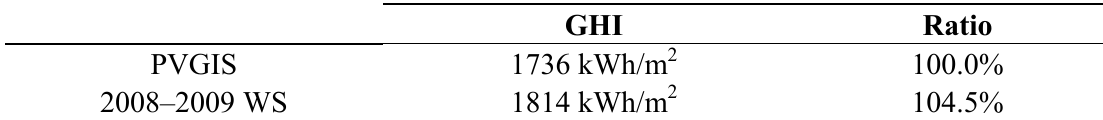
Table 7. PVGIS GHI, real GHI from weather stations, and their ratios from May 2008 to April 2009, at the Sanlúcar location.